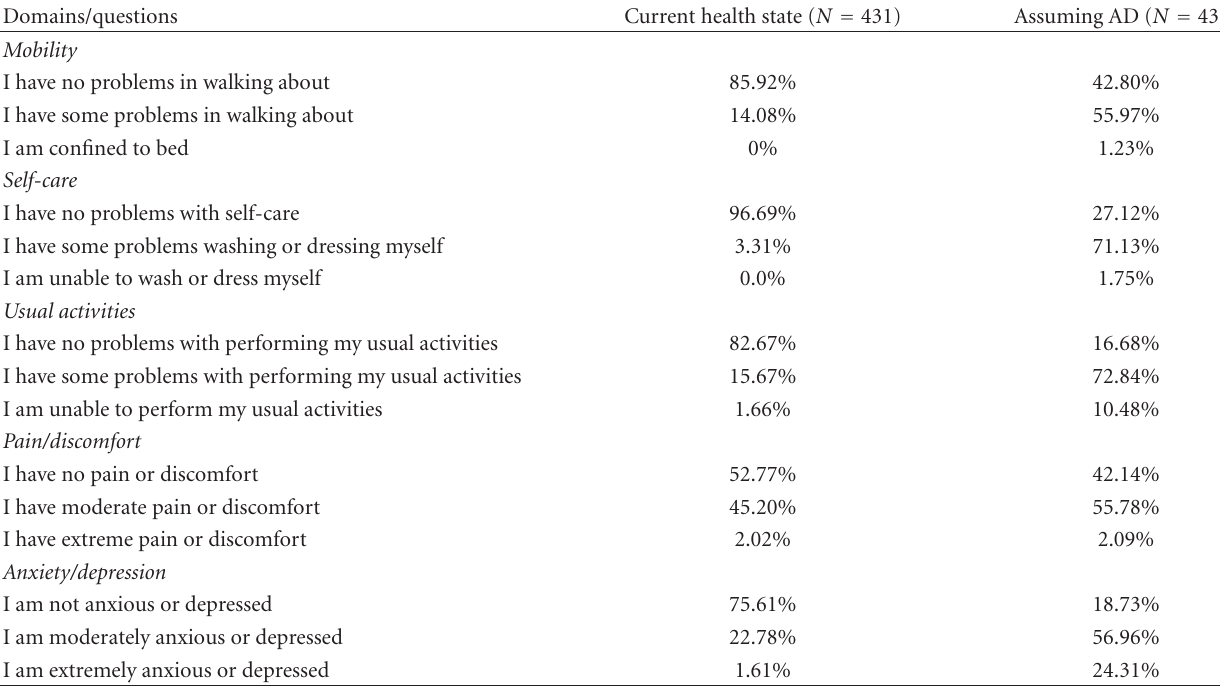
Table 2: Domains of EQ-5D: current and hypothetical moderate AD health state (weighted results).